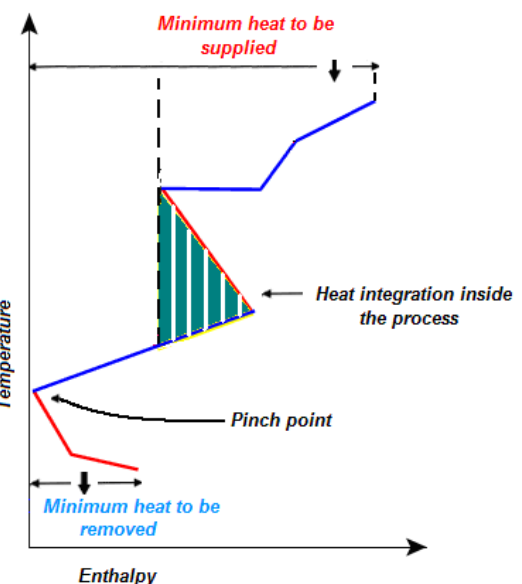
Figure 2. Grand composite curve of a generic process.